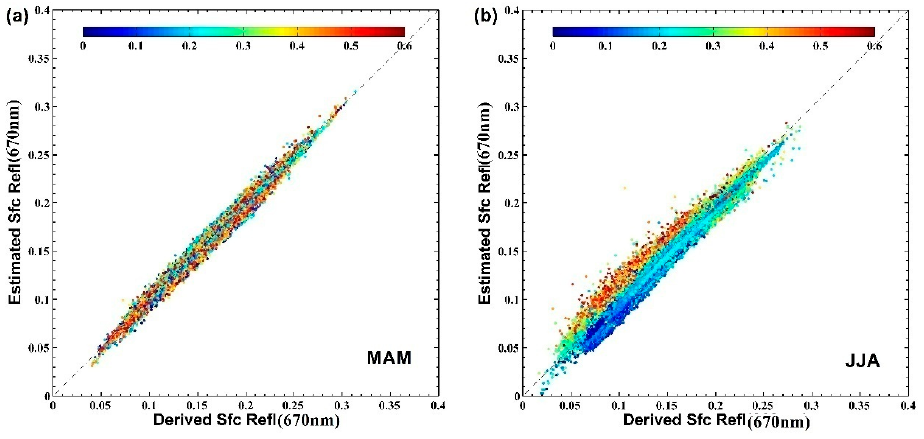
Figure 3. MOD09 surface reflectance at 0.67 µm ( a ) and 0.47 µm ( b ) as function of Rayleigh-corrected TOA reflectance at 0.86 µm and NDVI’ for the summer season. Color bar shows the values of the NDVI’ for each